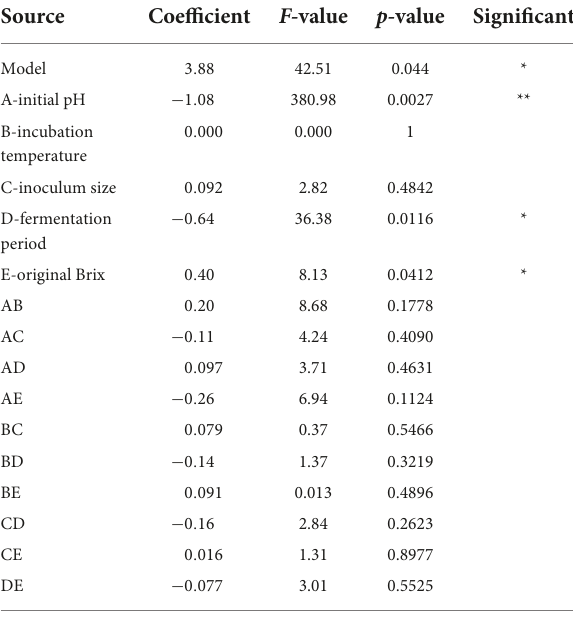
three parameters for β -damascenone production. The three- factor [initial pH (A), original biomass (B), and fermentation period (C)] and three-level experimental design of 17 trials and